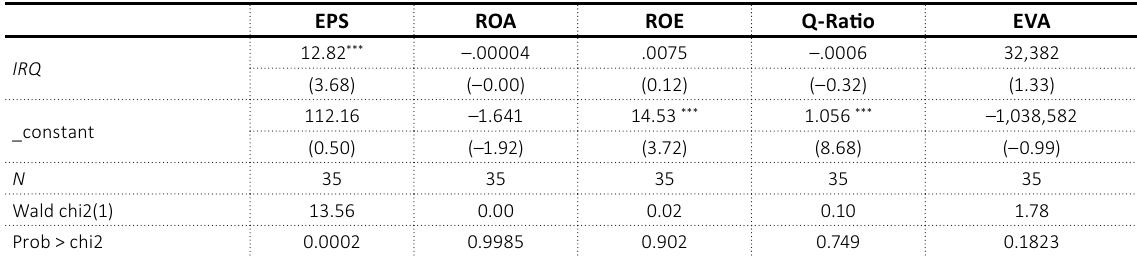
Table 3. Parameter estimates of the FGLS models